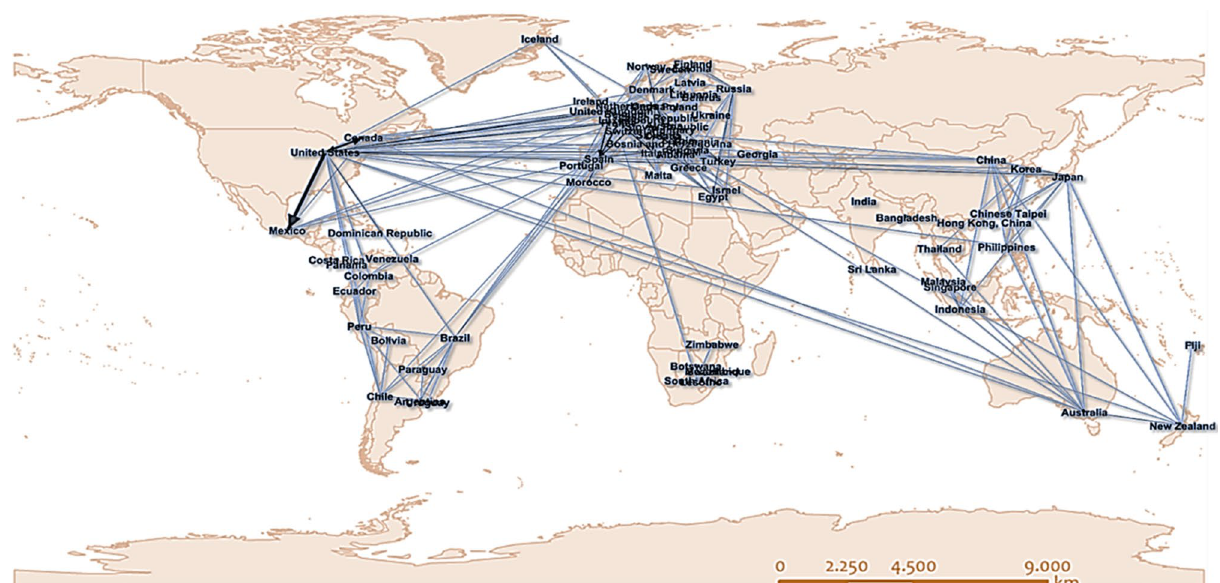
Figure 2. The graph model of the directed GTN (data of the year 2018, own elaboration based on ESRI ArcGIS 10.50; https:// www. arcgis.